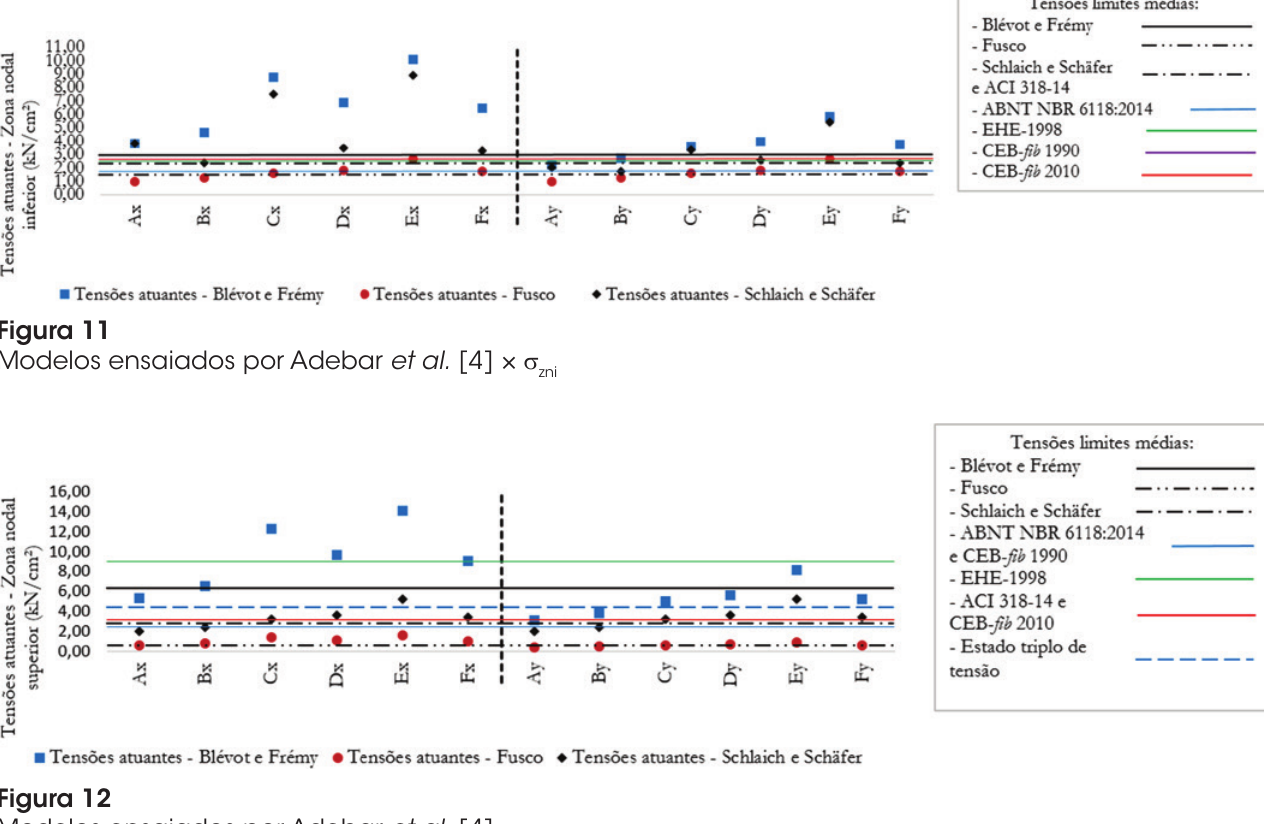
Modelos ensaiados por Adebar et al. [4] × σ